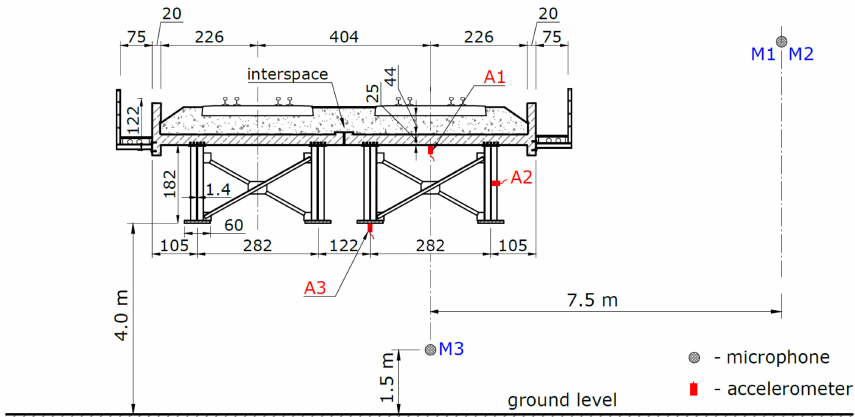
Figure 2. Cross-section of the tested bridge and measuring points.